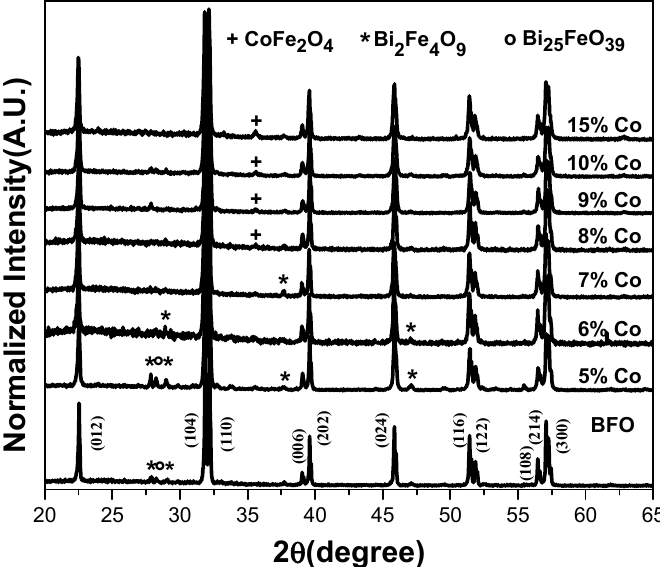
Figure 1. XRD patterns for Co-doped BFO powders thermally treated at 700 °C for 30 min. Incorporation of Co species in Bi sites should give place to a shrinking in the unit cell due to the mismatch in ionic radii between Co 2 + (0.78 Å) and Bi 3 + (1.20 Å);